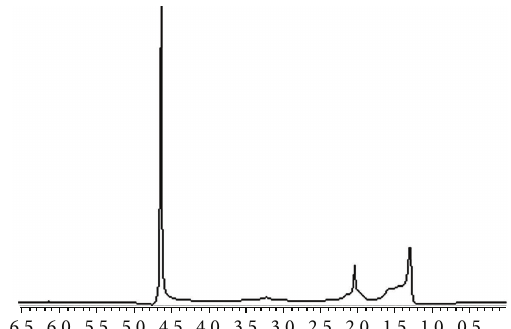
Figure 2: 1 H-NMR spectrum of copolymer AM/AMPS 90: 10.